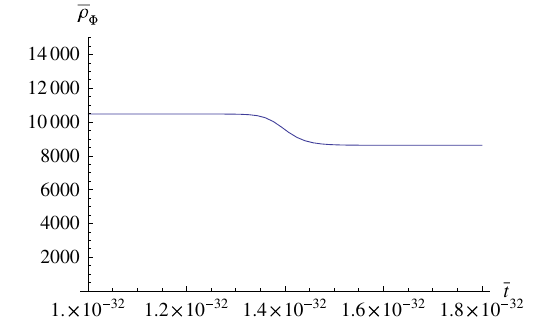
Fig. 8 The diagram presents the evolution of ¯ ρ Φ with respect to the cosmological time ¯ t . The time is expressed in seconds and ¯ ρ Φ is expressed in km 2 . The value of the parameter γ is assumed as s 2 Mpc 2 = 0 . 6911, where 3 . 277 × 10 − 6 s 2 Mpc 2 . We also assume that Λ km 2 3 H 2 0 H 0 = 67 . 74 km . Note that ¯ ρ Φ is not a constant function when matter s Mpc is not negligible (see Fig. 4). It is interesting that the function ¯ ρ Φ is of the logistic-like function type